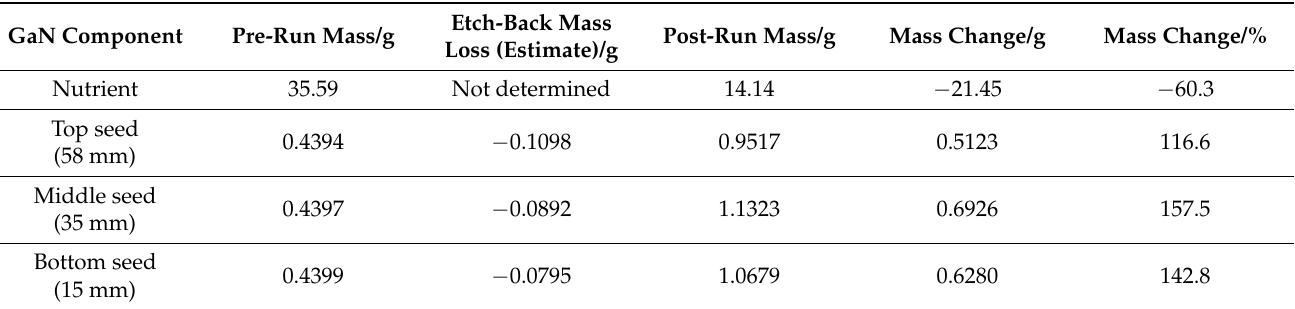
Table 7. Masses of GaN components before and after the ammonothermal growth experiment. Changes with negative values represent a decrease in mass. Note that the bottom edges of the bottom